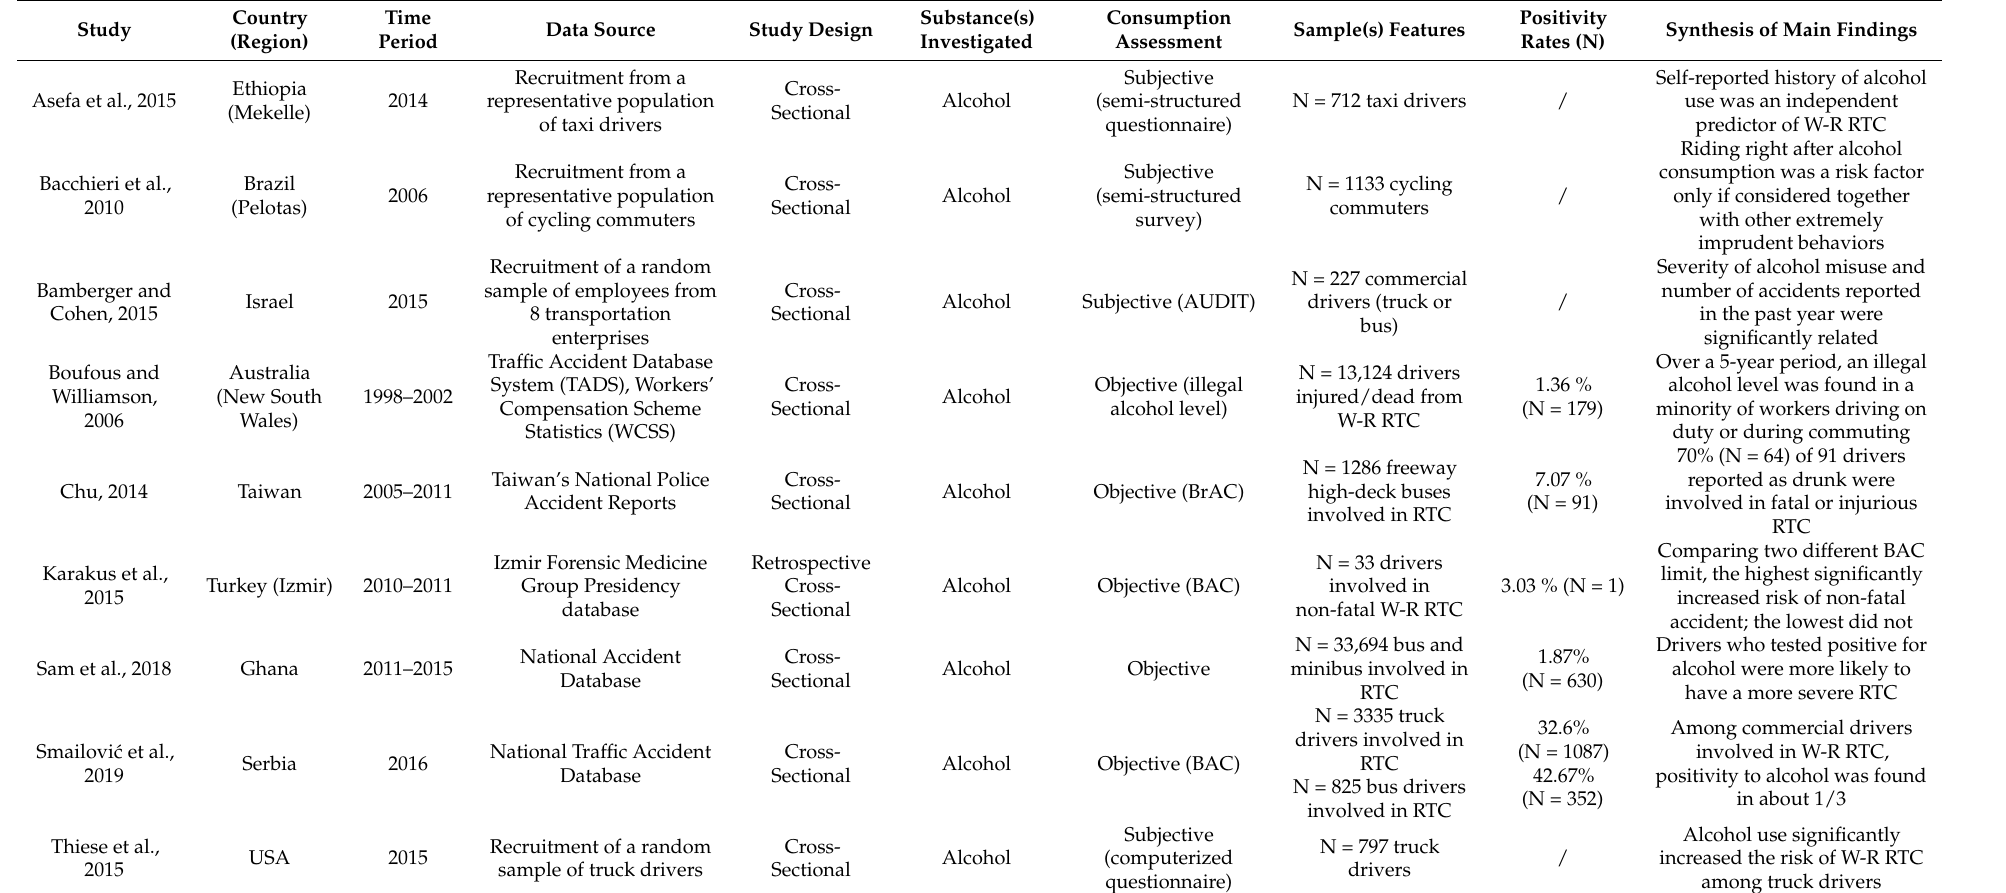
Table 3. Retrieved studies and their main